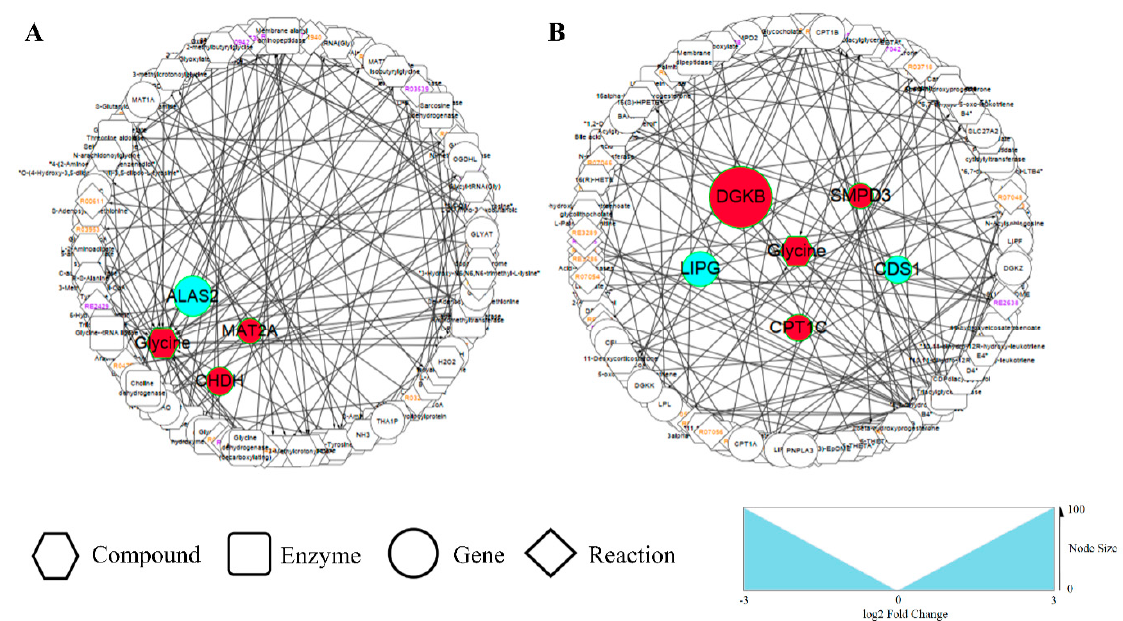
Figure 4. Network of genes and metabolites regulated by G. elegans . Network visualization of the amino acid metabolism ( A ) and lipid metabolism pathways ( B ) was performed using Cytoscape software (version 3.5.1) and MetScape software (version 3.1.3). The node colors in this figure correspond to absolute maximum log2 fold changes; significant increases and decreases in differential metabolites and differentially expressed genes are highlighted in red and blue, respectively.